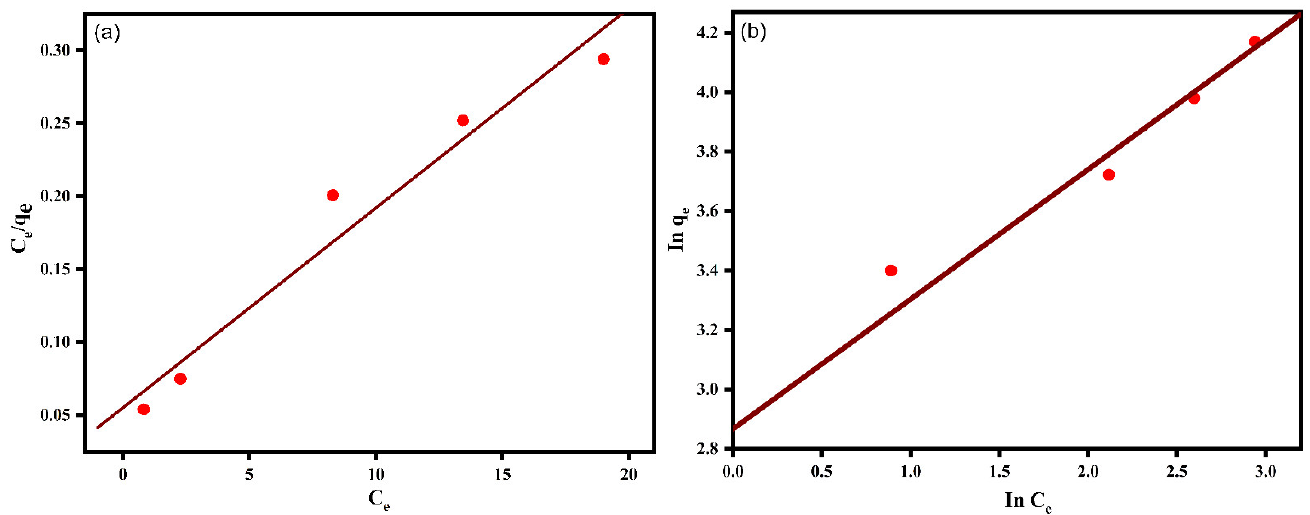
Figure 12. Linear isotherm plots of CR onto agar/zeolite/CMC/PVA biomembrane ( a ) Langmuir ( b ) Freundlich models. Table 7. Langmuir and Freundlich isotherm parameters for anionic dye adsorption.